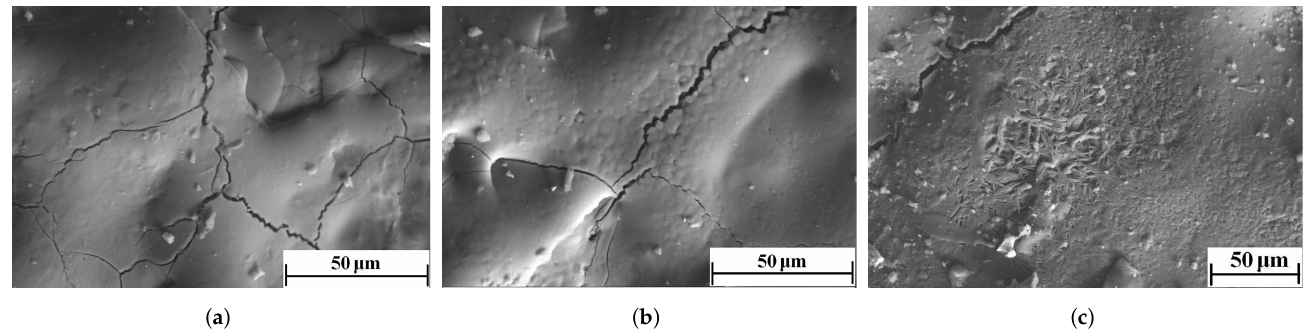
Figure 3. SEM images (top view) of the arc-treated cathodes: ( a ) Al 0.7 Cr 0.3 ; ( b ) Al 0.65 Cr 0.25 Si 0.1 ; ( c ) Al 0.6 Cr 0.2 Si 0.2